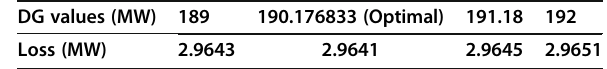
Table 12 Comparison of real power loss at the IEEE 14 bus system with different DG power placed at bus no. 4 using the JAYA algorithm